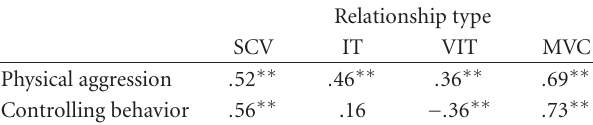
Table 5: Associations between self (women’s) and partner (men’s) use of acts physical aggression and controlling behaviors by rela- tionship